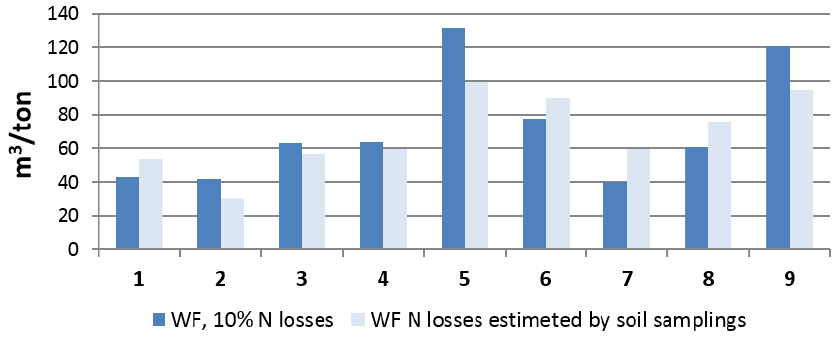
Figure 3. WF total estimated by the different WF grey estimation methods. Figure 4. WF total estimated by the different WF grey estimation